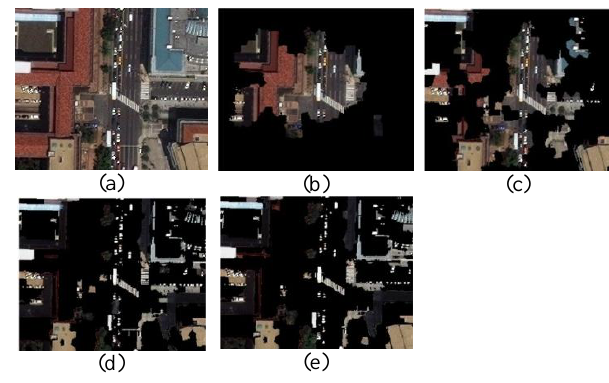
Figure 10. (a) original image, (b) SS&KD, (c) Rare2012, (d) Achanta 08, (e) Achanta 09